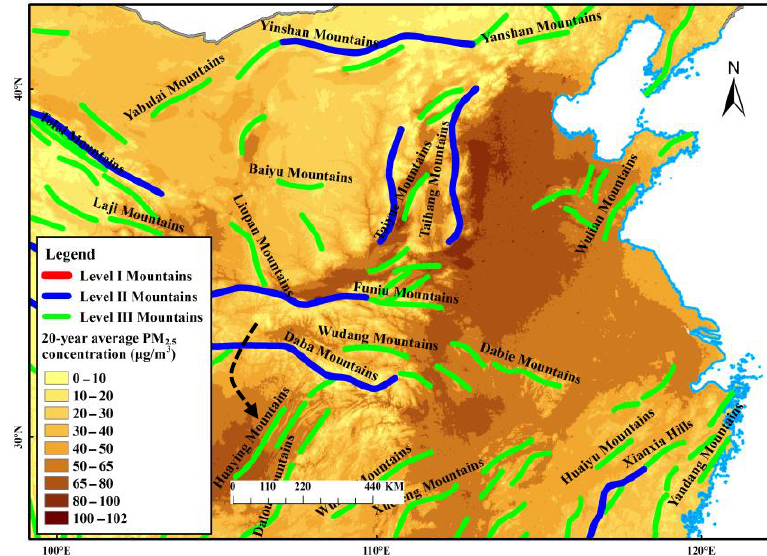
Figure A5 . Local distributions of the mountain ranges in China . Figure A5. Local distributions of the mountain ranges in